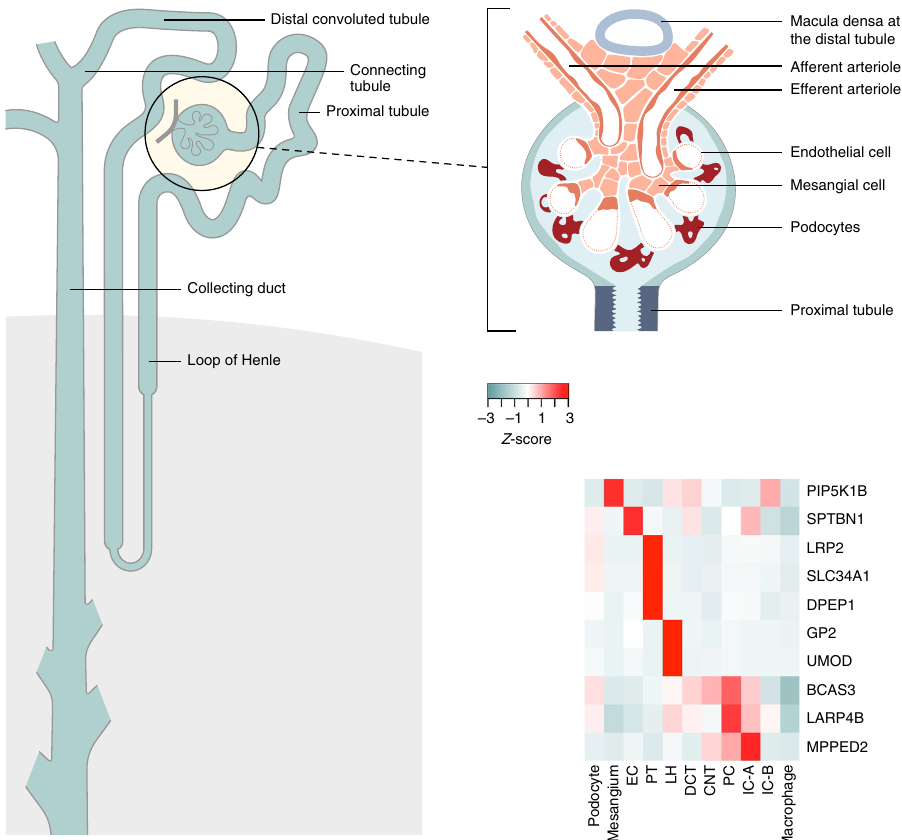
Fig. 1 Differential kidney single-cell gene expression in nephron segments. The left and top right panels highlight nephron segments and glomerulus cells, respectively. The heatmap in the bottom right panel presents Z -score normalized average gene expression for each speci fi c kidney cell cluster in human adult kidney cells: EC, endothelial cells; PT, proximal tubular cells; LH, loop of Henle cells; DCT, distal convoluted cells; CNT, connecting tubular cells; PC, principal cells; IC-A, intercalate cells type A (located in the collection duct at the distal nephron); IC-B, intercalate cells type B (located in the collection duct at the distal nephron). Source data are provided as a Source Data fi